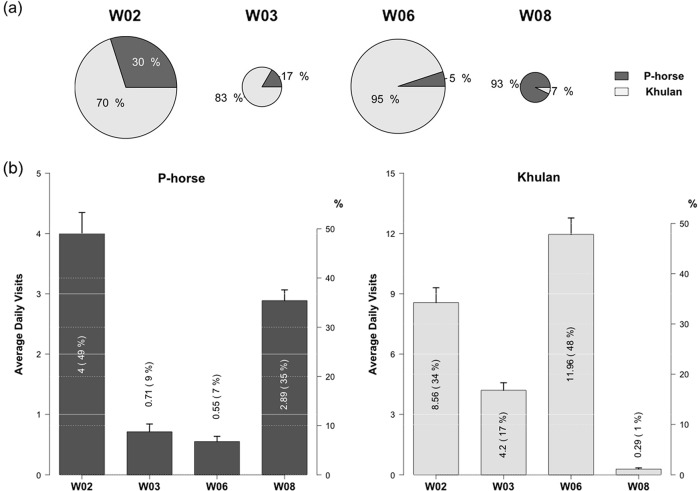
The percentages (a) and frequencies (b) of average daily water visits by P-horse and Khulan at four water points.The texts inside bars are the average number and percentage of water visits by each equid per day per water point. Error bars represented the standard error (SE).